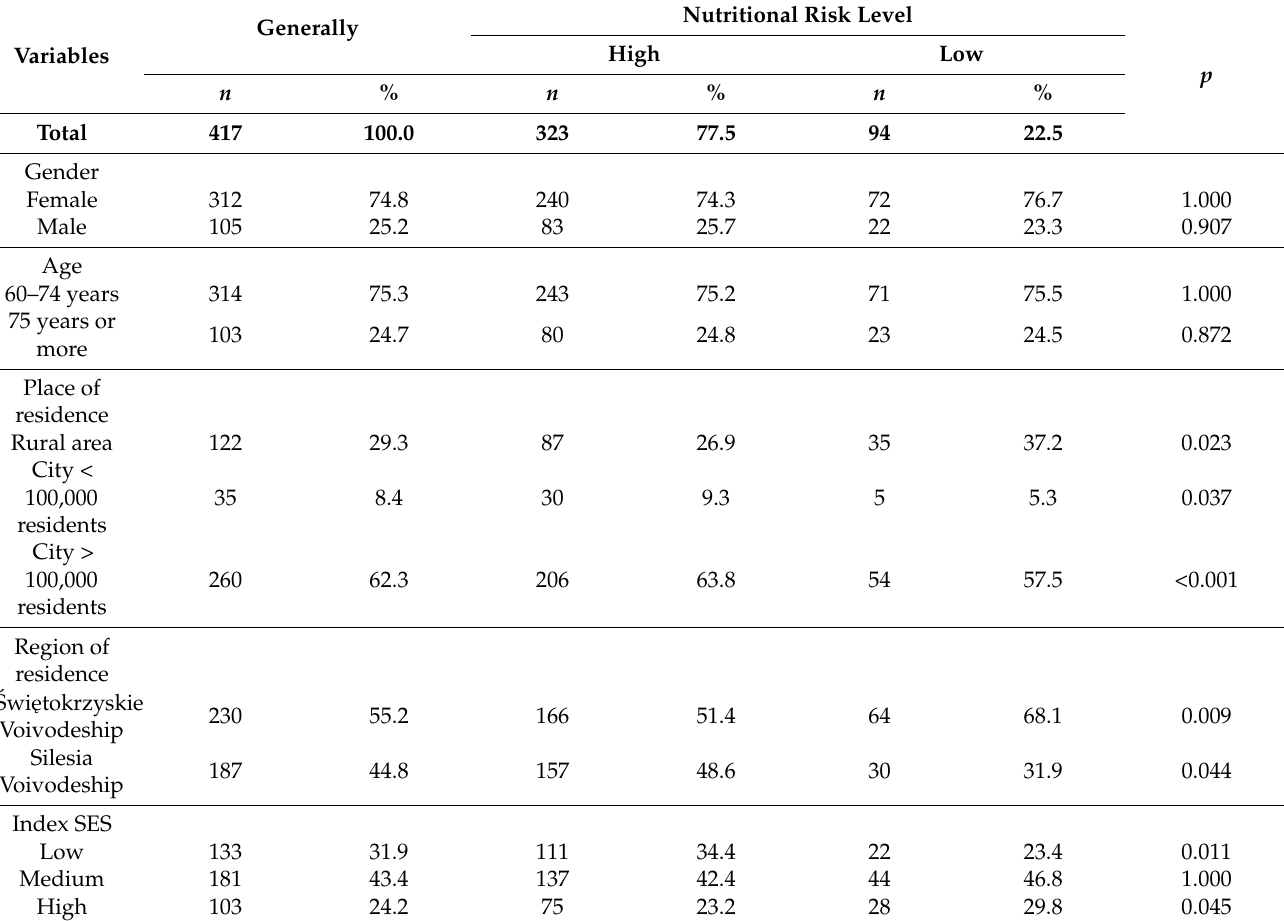
Table 2. Occurrence of nutritional risk depending on selected demographic characteristics and socioeconomic